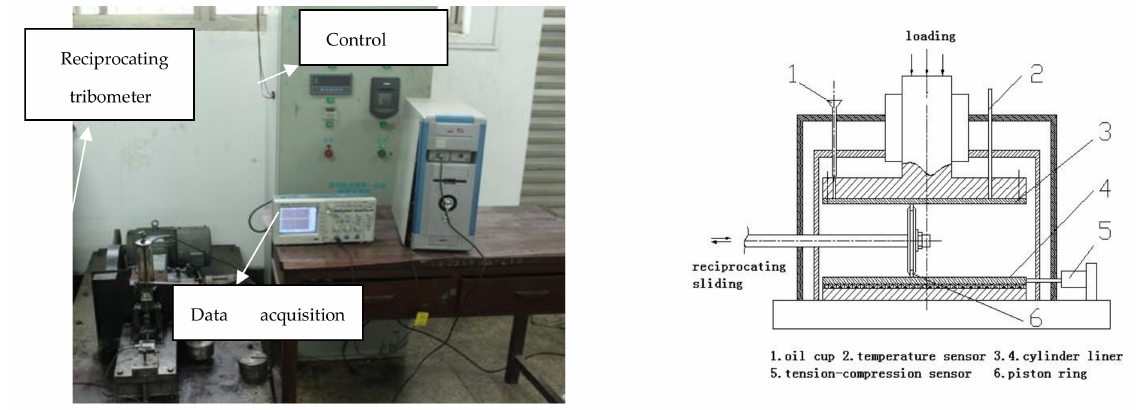
Figure 1. The sketch map of the piston ring–cylinder liner in the reciprocating